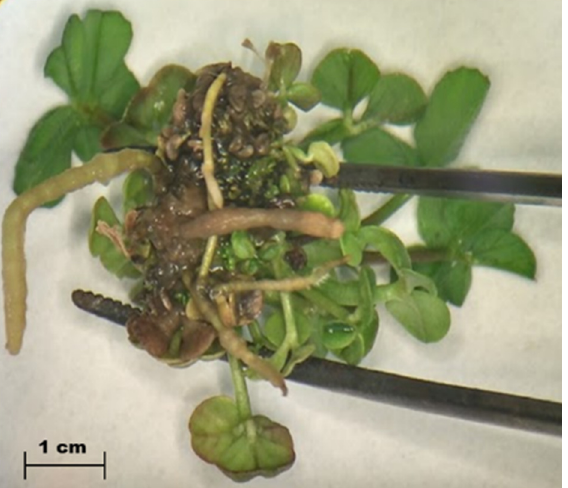
Figure 1. Explant cultivated for two months in rooting medium containing 1.2 µM IAA. Presence of multiple roots coming out from the bottom part of the explant. Image captured under stereo- microscope Leica MZ6 ® .